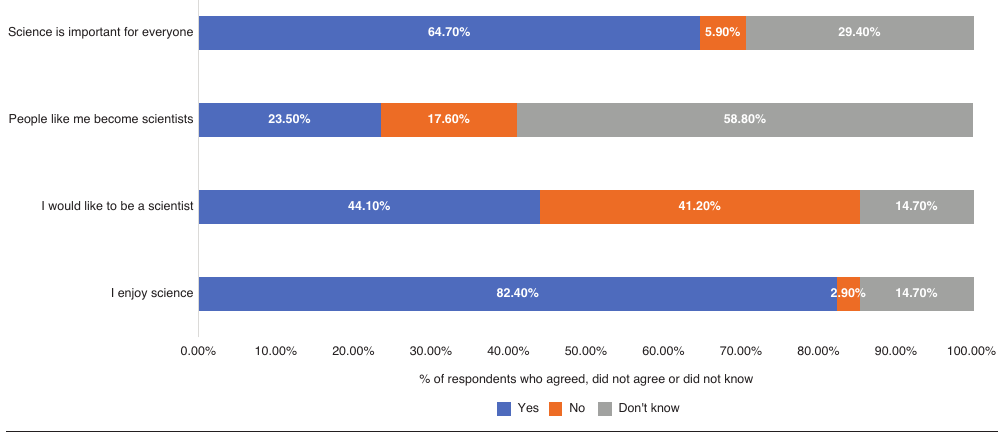
Figure 4: Respondents’ views of science prior to the start of the School Science Club (percentages from 352 responses) (source: